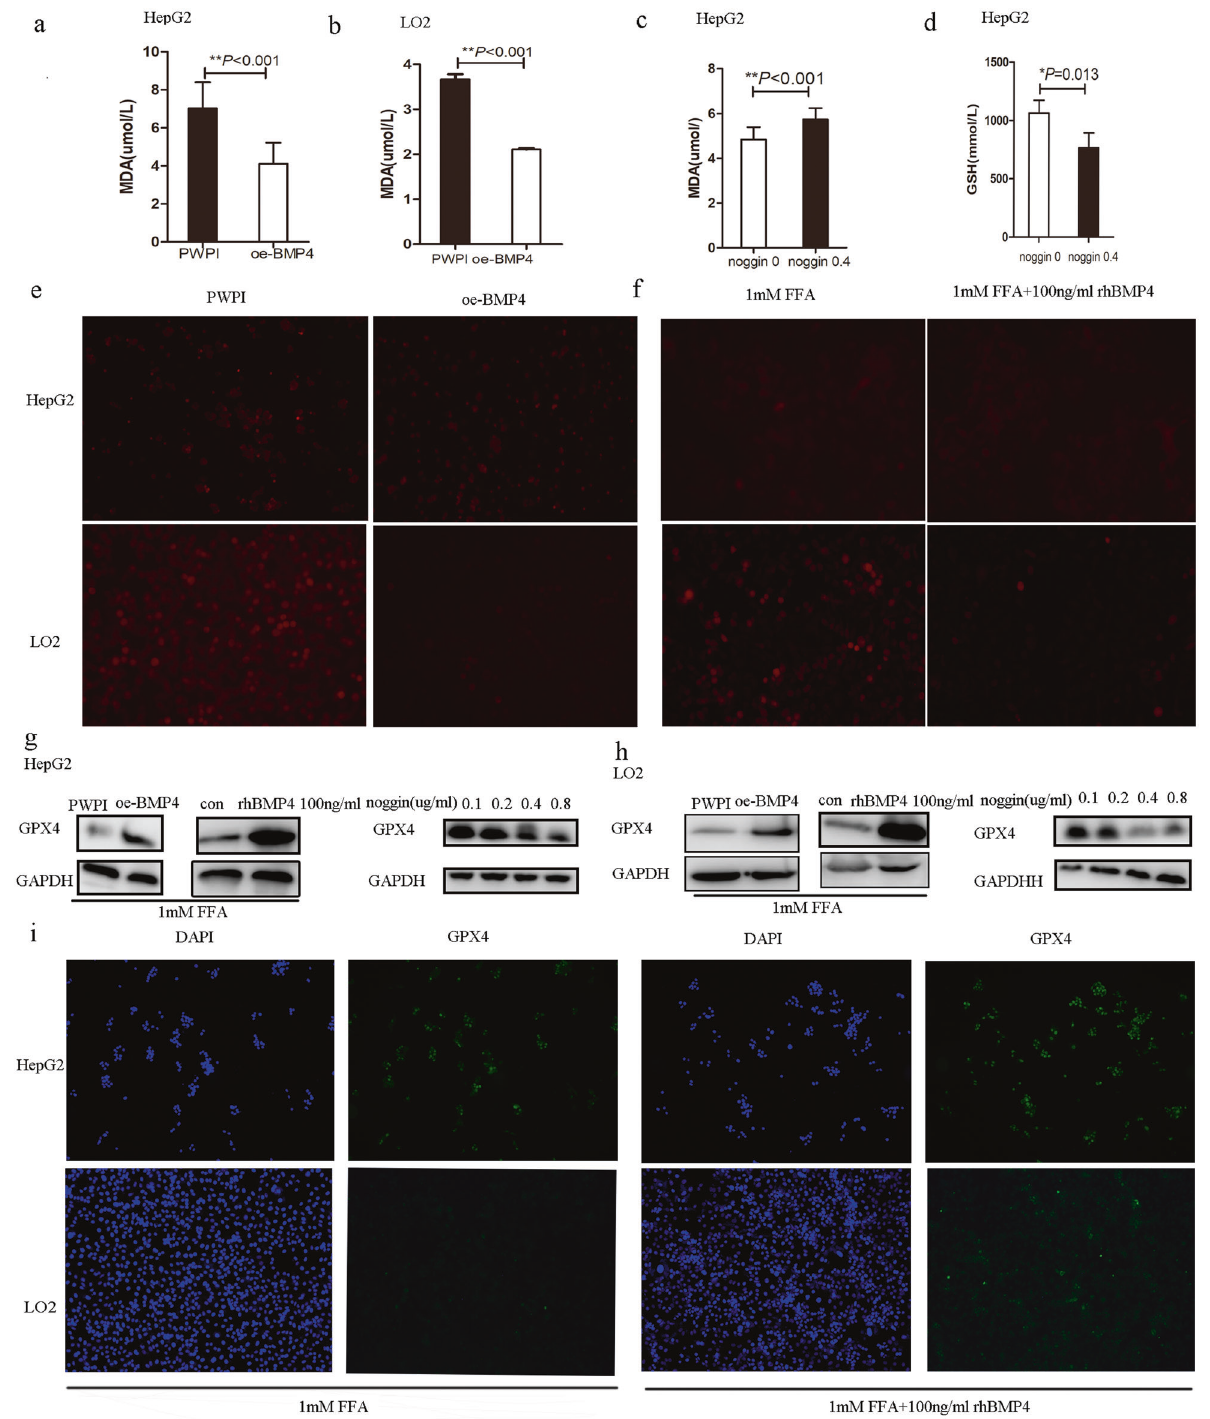
Fig. 5 BMP4 relieves ferroptosis of NASH in FFA-induced hepatocytes. a , b MDA levels in oe-BMP4 group and control group in HepG2 and LO2 cells, ** p < 0.001. c MDA levels in noggin added and control group in HepG2 cells, ** p < 0.001. d GSH levels in noggin added and control group in HepG2 cells, * p < 0.05. e ROS expression in oe-BMP4 group and control group in HepG2 and LO2 cells. f ROS expression in rhBMP4 added and control group in HepG2 and LO2 cells. g , h Western blot analysis of GPX4 expression in oe-BMP4 or noggin added group and control group in HepG2 and LO2 cells. i IF of GPX4 expression in FFA-induced HepG2 and LO2 cells with or without rhBMP4 added.